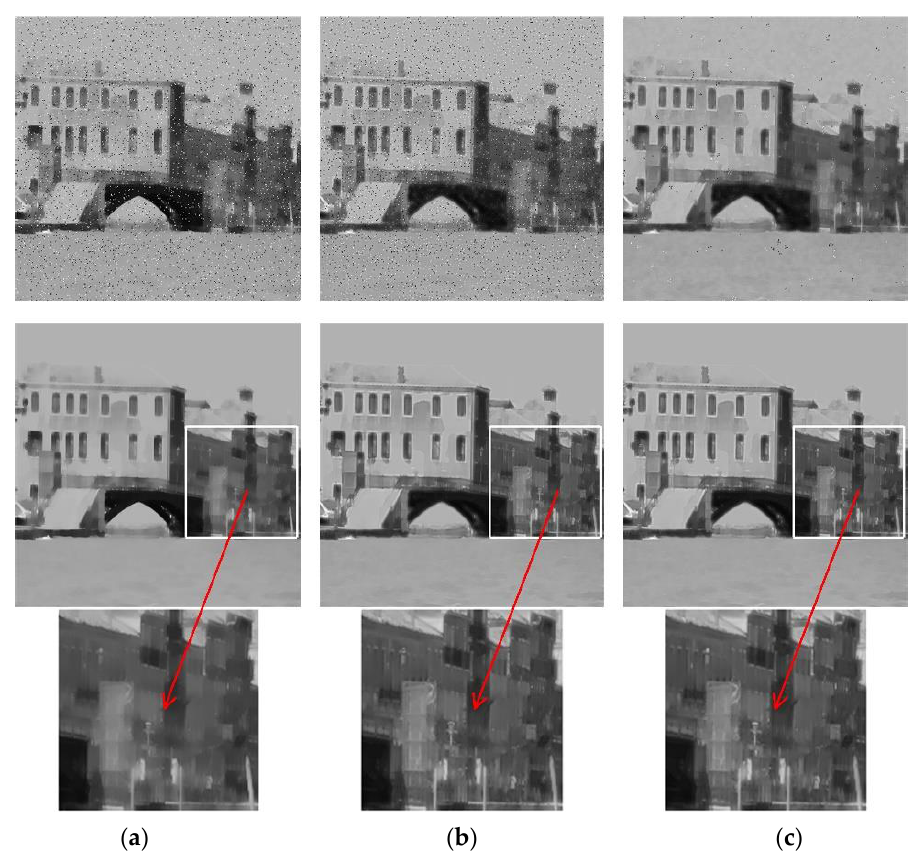
Figure 9. Results of the two algorithms for denoising and contrast enhancement. ( a ) Original image; ( b ) images enhanced by Equation (14); ( c ) images enhanced by Equation (15).